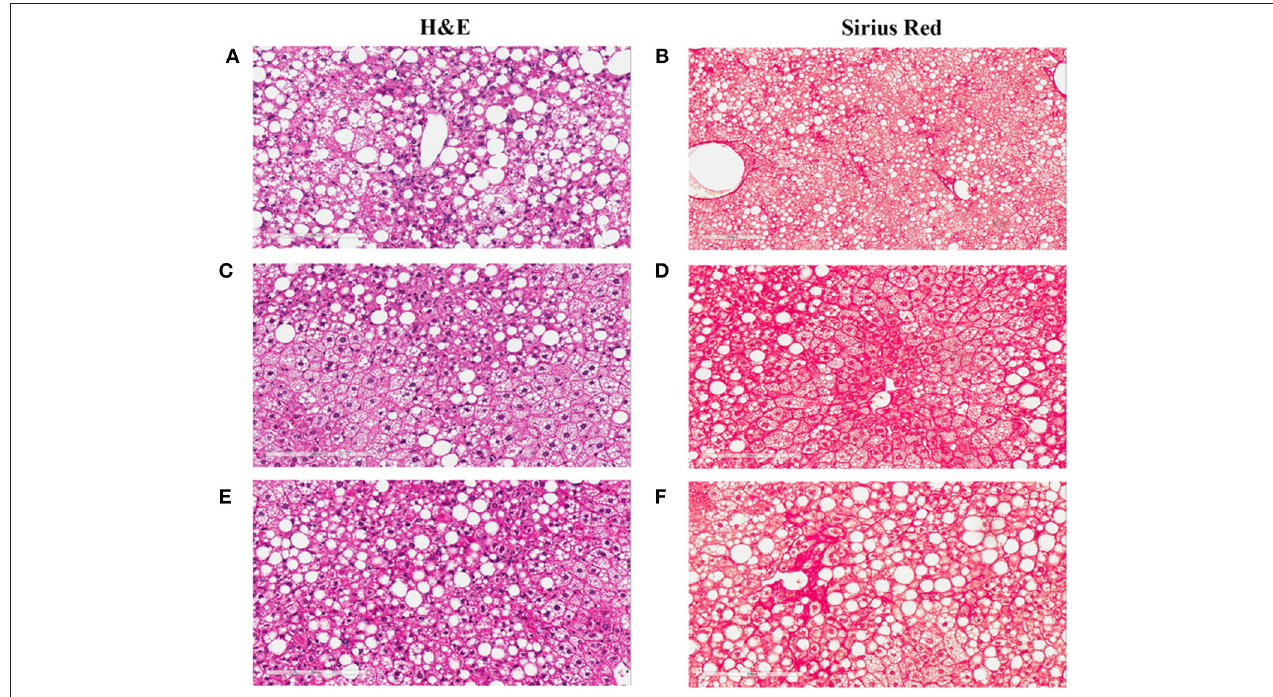
FIGURE 9 | Liver images of the NASH mice treated with Ocaliva (OCA) and Cenicriviroc (CVC). The representative images were taken from the liver sections of the NASH mice treated with vehicle (A,B) , 20 mg/kg/day (C,D) , and 40 mg/kg/day (E,F) of OCA. (A,C,E) are the images of the liver sections stained with H&E; (B,D,F) are the images of the liver sections stained with Sirius